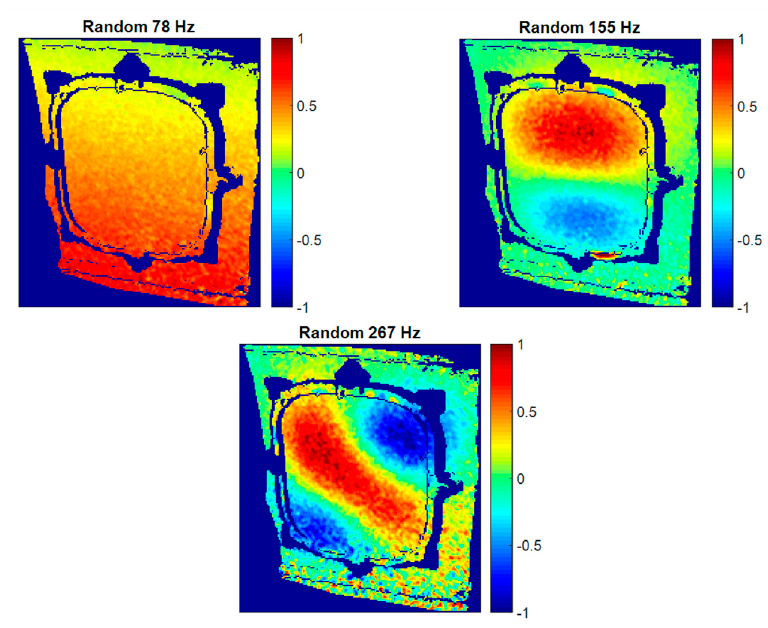
Figure 14. Additional normalized ODSs in the out-of-plane direction detected using HS 3D-DIC and random excitation.